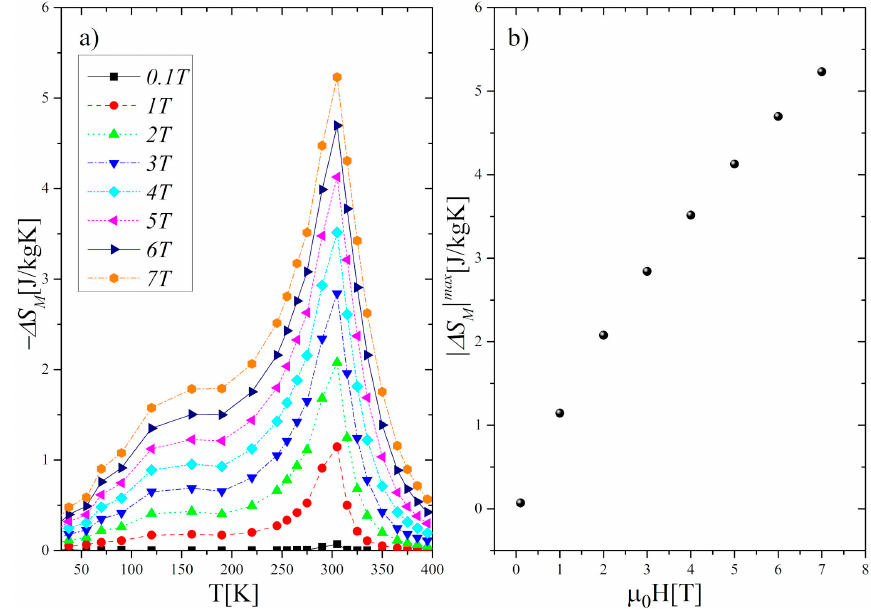
Figure 7. ( a ) Magnetic entropy changes ( − ∆ S M ) in the Gd 0.4 Tb 0.6 Co 2 as a function of temperature and magnetic field. ( b ) Variation of the maximum of the magnetic entropy changes | ∆ S M | max with the growth of a magnetic field.